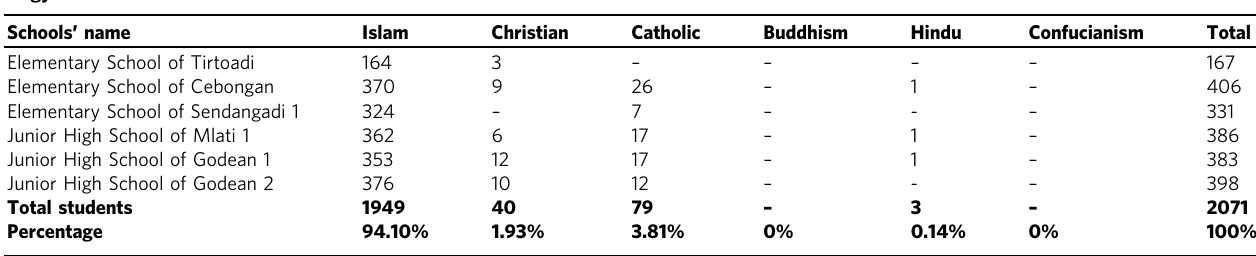
Table 2 Demographic information of students ’ religion on sample schools in Sleman regency,